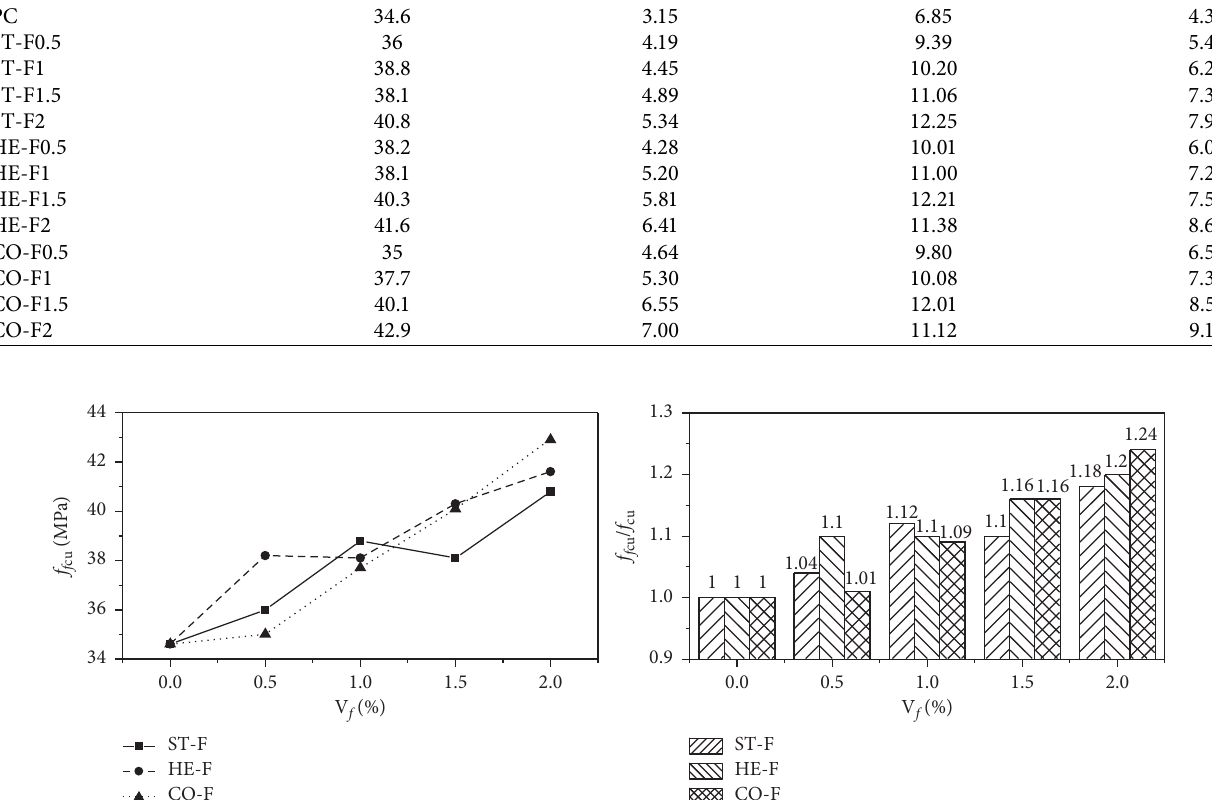
Figure 4: Relationship between f